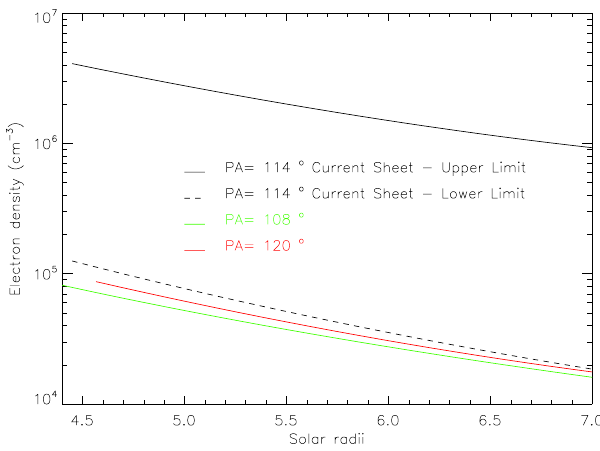
Fig. 7. Profile of the CS density vs. heliocentric distance, derived from the LASCO pB map at 22:55UT, under the assumption of spherical symmetry (dotted line) and under the assumption of a CS length (along the LOS) equal to the CS width on the plane of the sky (solid line). Green and red lines give coronal densities in regions adjacent to the